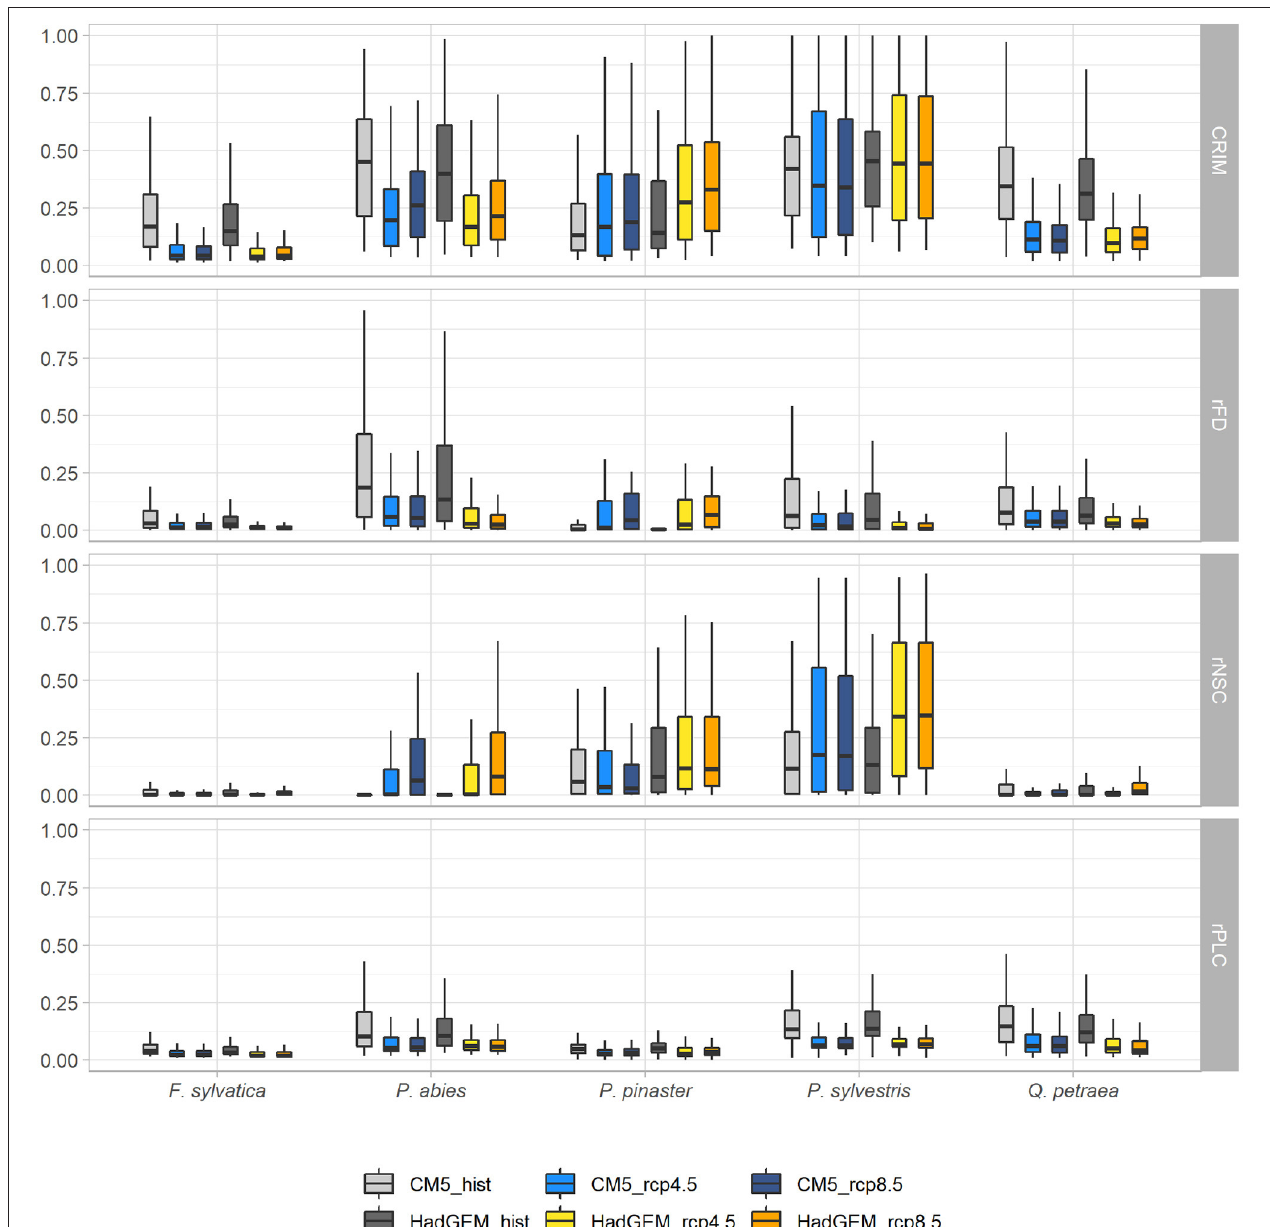
FIGURE 3 | Variation of the mean values of mortality risk indices ( CRIM , rFD max , rNSC , and rPLC ) under two current and four future climatic scenarios. Each whisker box represents the distribution of risk indices values across the simulated range (with the median as the horizontal line, the interquartile range as the box, and the minimal and maximal values at the ends of the vertical lines). Each future climatic scenario (in blue for the CM5 RCM and in orange for the HadGEM RCM) can be compared to their historical reference (in light and dark gray for the CM5 and HadGEM RCMs, respectively). Simulations were run without management (SS1).